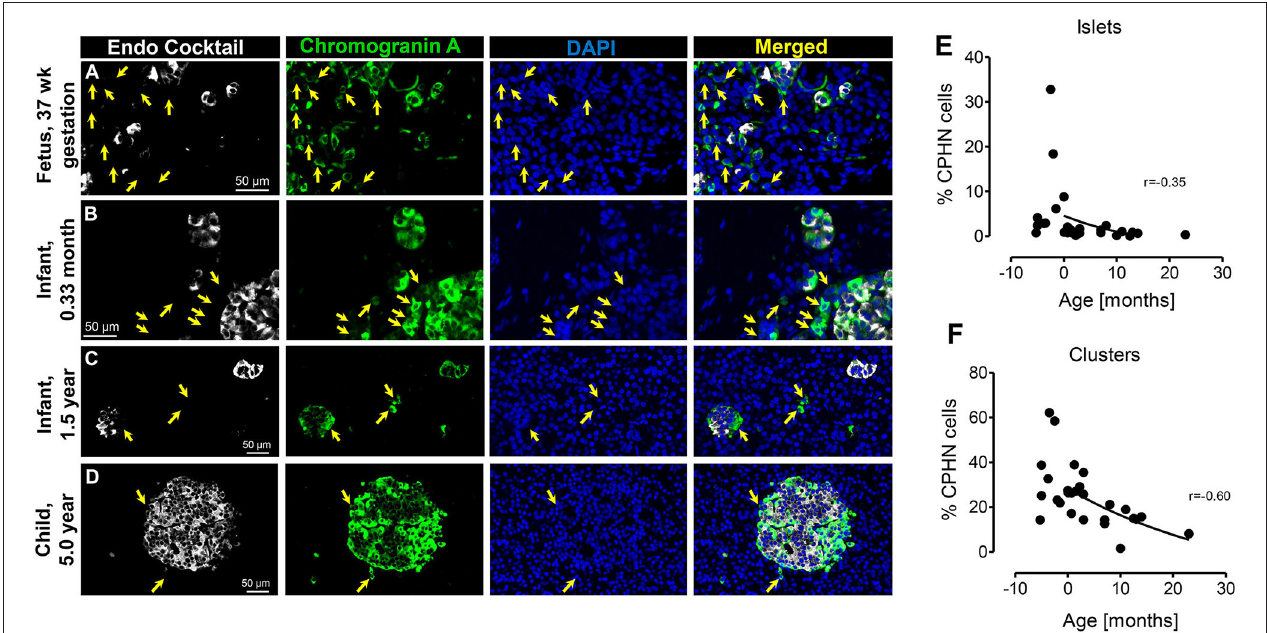
FIGURE 1 | The frequency of chromograninA positive hormone-negative (CPHN) cells decreases with age. Representative pancreatic sections from fetal (A) and infant-child (B–D) cases immunostained for Endocrine cocktail (insulin, glucagon, somatostatin, pancreatic polypeptide, and ghrelin) (white), chromograninA (green), and DAPI (blue). Yellow arrows show CPHN cells. Frequency of CPHN cells in islets (E) and clusters (F) . Scale bars, 50 µ m.